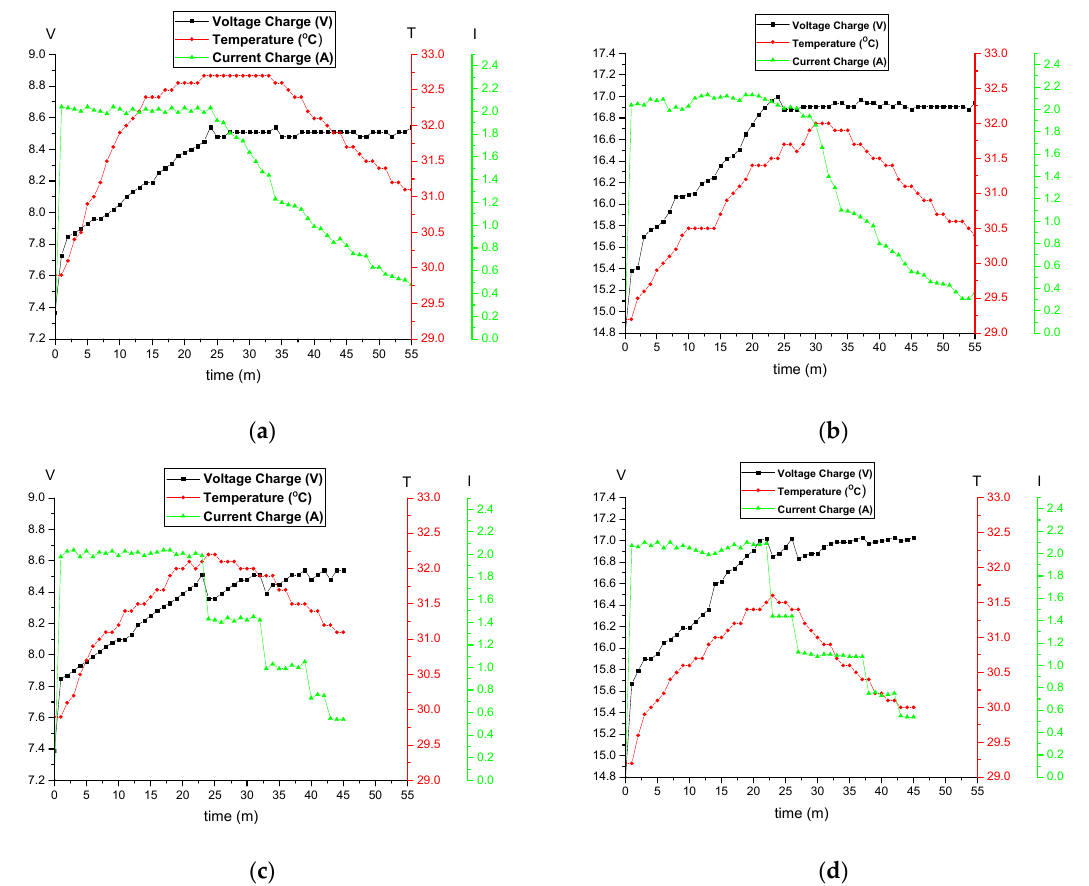
Figure 10. Charging process: ( a ) 2S-CCCV; ( b ) 4S-CCCV; ( c ) 2S-MSCC; ( d ) 4S-MSCC.